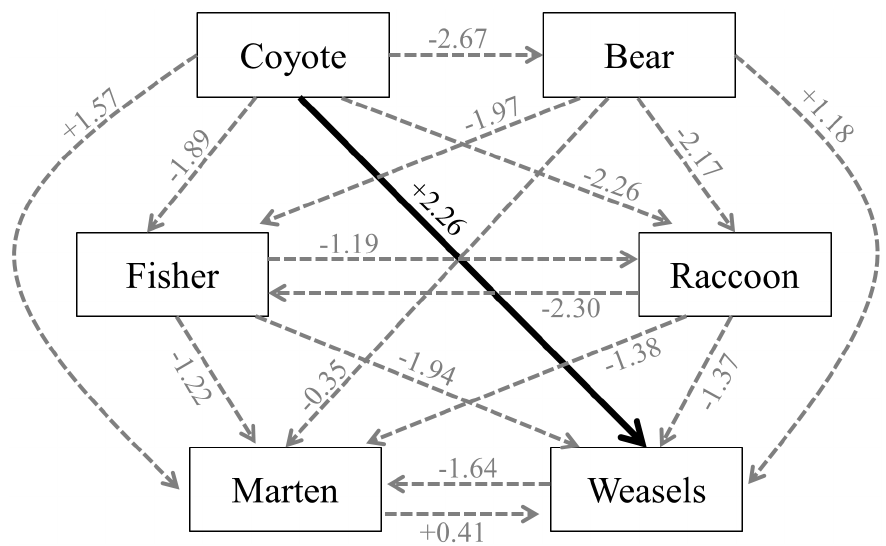
Fig 2. Extent to which adding interactions with another species improved (+) or worsened (-) the performance of the best habitat model (in terms of Δ AIC c scores) for study sites in New York ’ s Adirondack landscape. In only one case (solid line) was a best model improved by > 2 AIC c units through the inclusion of another carnivore